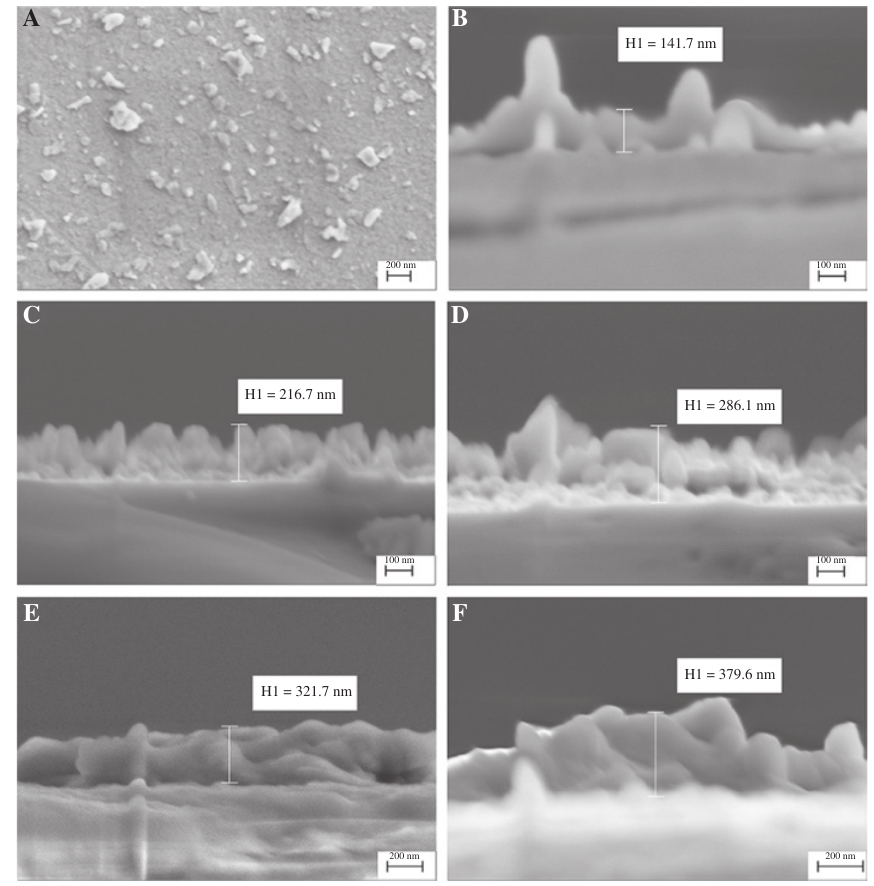
Figure 4: The scanning electron microscope (SEM) image of GeSe nanosheets. (A) The GeSe surface topography of the presented SPR sensor. SEM images of GeSe nanosheets cross section with different spin coating times for (B) one; (C) two; (D) three; (E) four; (F)